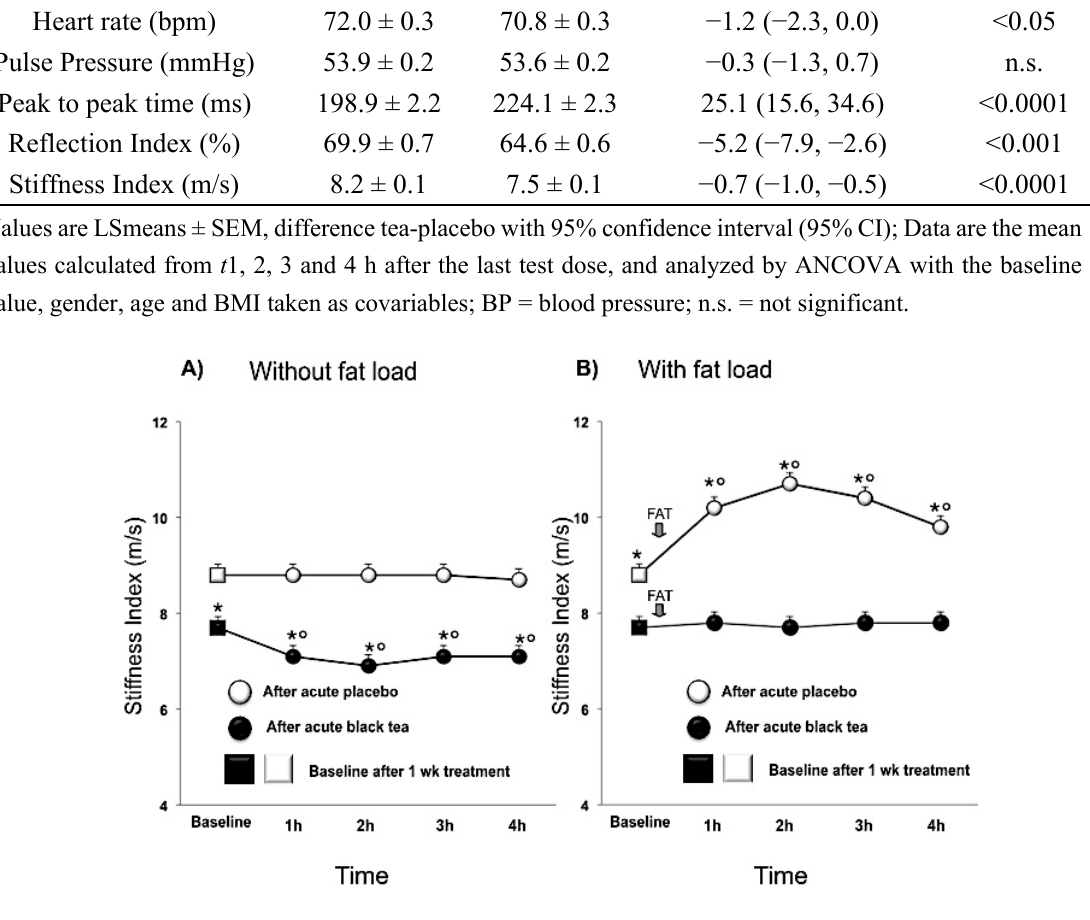
Figure 1. Effect of 1 week placebo (white) and black tea (black) administration on baseline (square) values (Panel A and B ) of stiffness index and acute effects without and with fat load (Panel A and B ). Data are presented as LSmeans ± SE. In all panels vertical lines indicate SE and asterisks (*) indicate significant differences with respect the placebo phase (Panel A and B ) while circles (°) indicate significant differences from baseline values (Panel A and B ). Differences are considered significant when p <